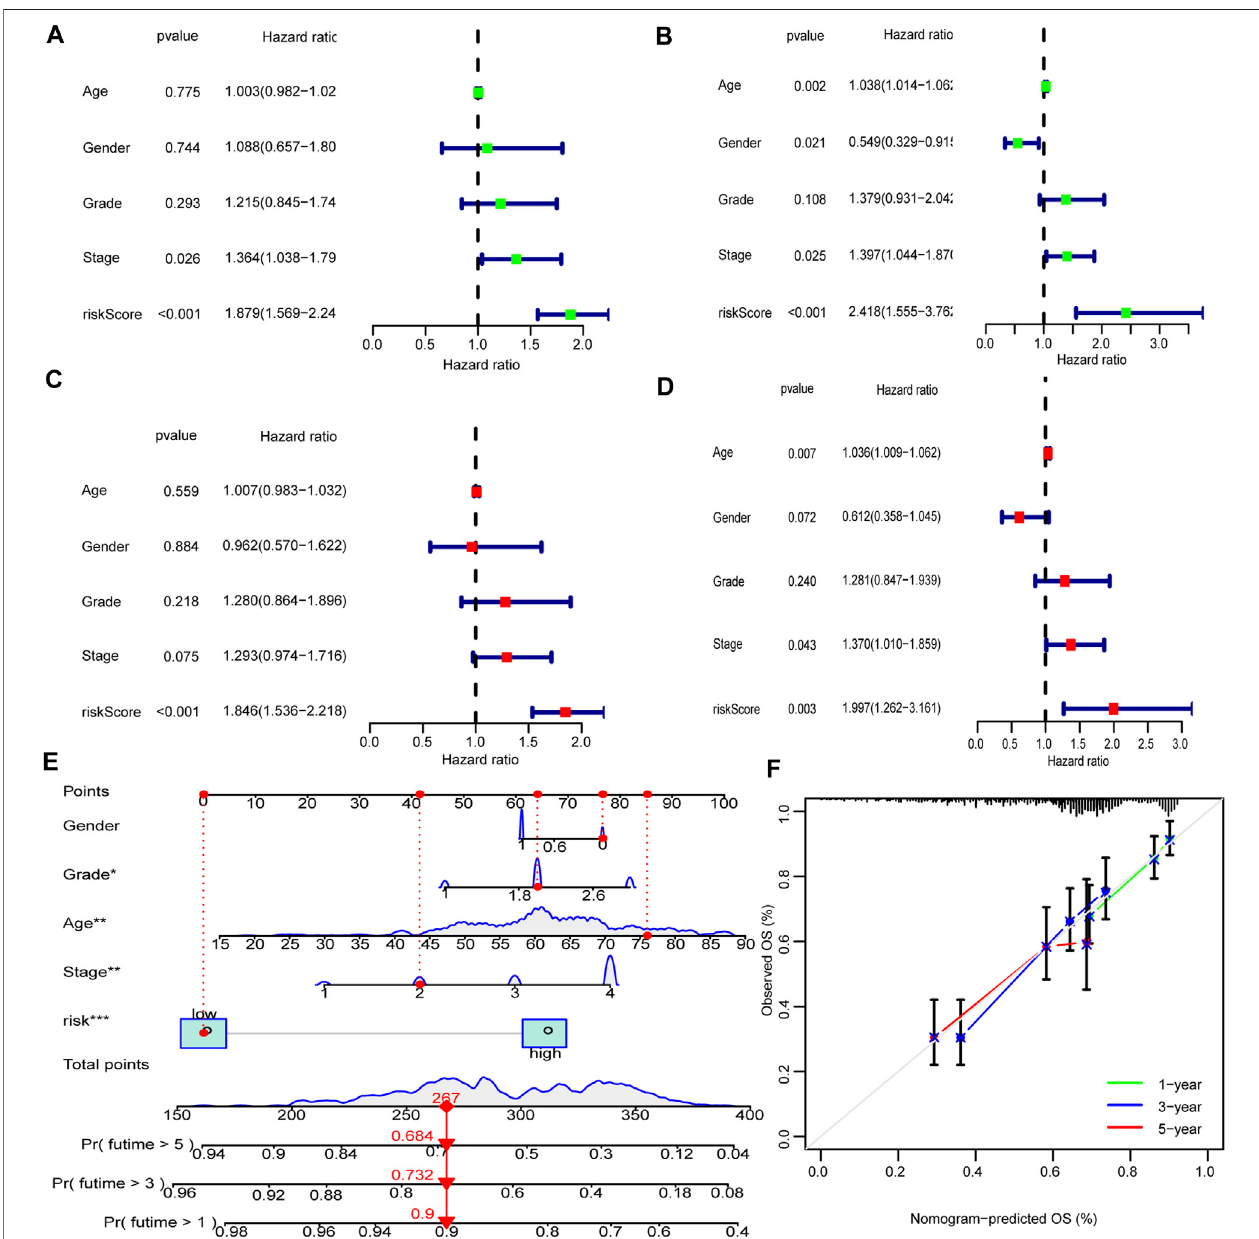
FIGURE5| Nomogram ofthemodel. (A,B) Tumorstage and riskscorewereriskfactors inthe training set. (C,D) Only riskscorewasriskfactor inthe testsets. (E) Thenomogramthatintegratedtheriskscore,age,andtumorstagetopredictOS. (F) ThecalibrationcurvesforOS. (G – I) ROCcurvesofthethreesets(trainingset:A,C, G; test set: B, D, H; entire set: